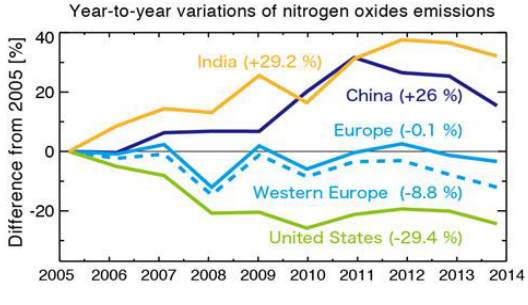
Fig. 2. Year-to-year variations of NO x